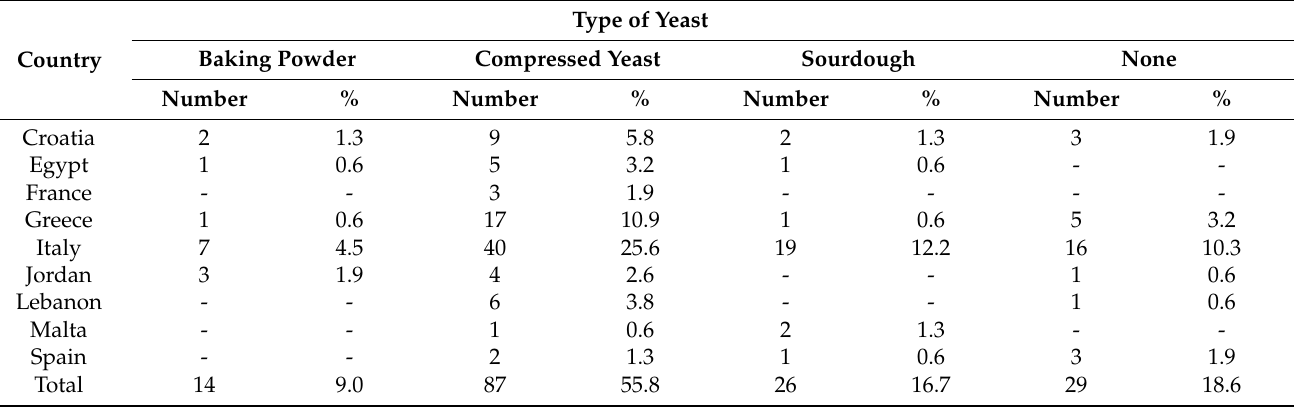
Table 5. Type of yeast, if any, used in the preparation of flat breads. Multiple answers were admitted, because breads could be prepared with different types of yeast or yeast